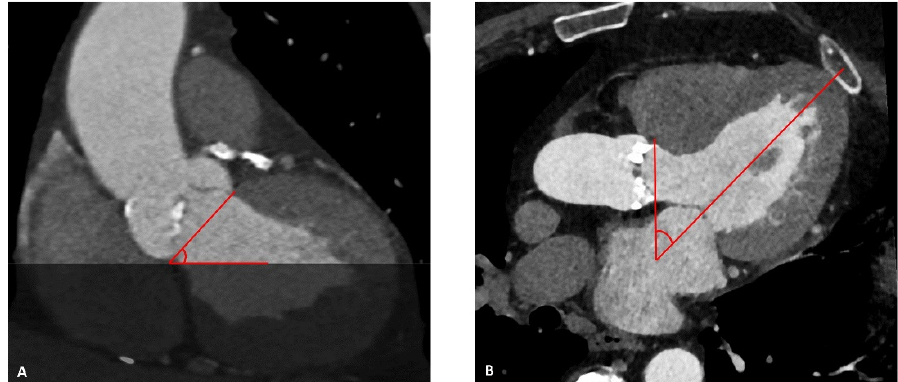
Figure 4. Assessment of aortic and annular angle. Pre-TAVI CTA reconstructions for measurement of the aortic angle between the annular and ideal horizontal plane ( A ) and the annular angle between the annular plane and the longitudinal axis of the left ventricle ( B ).